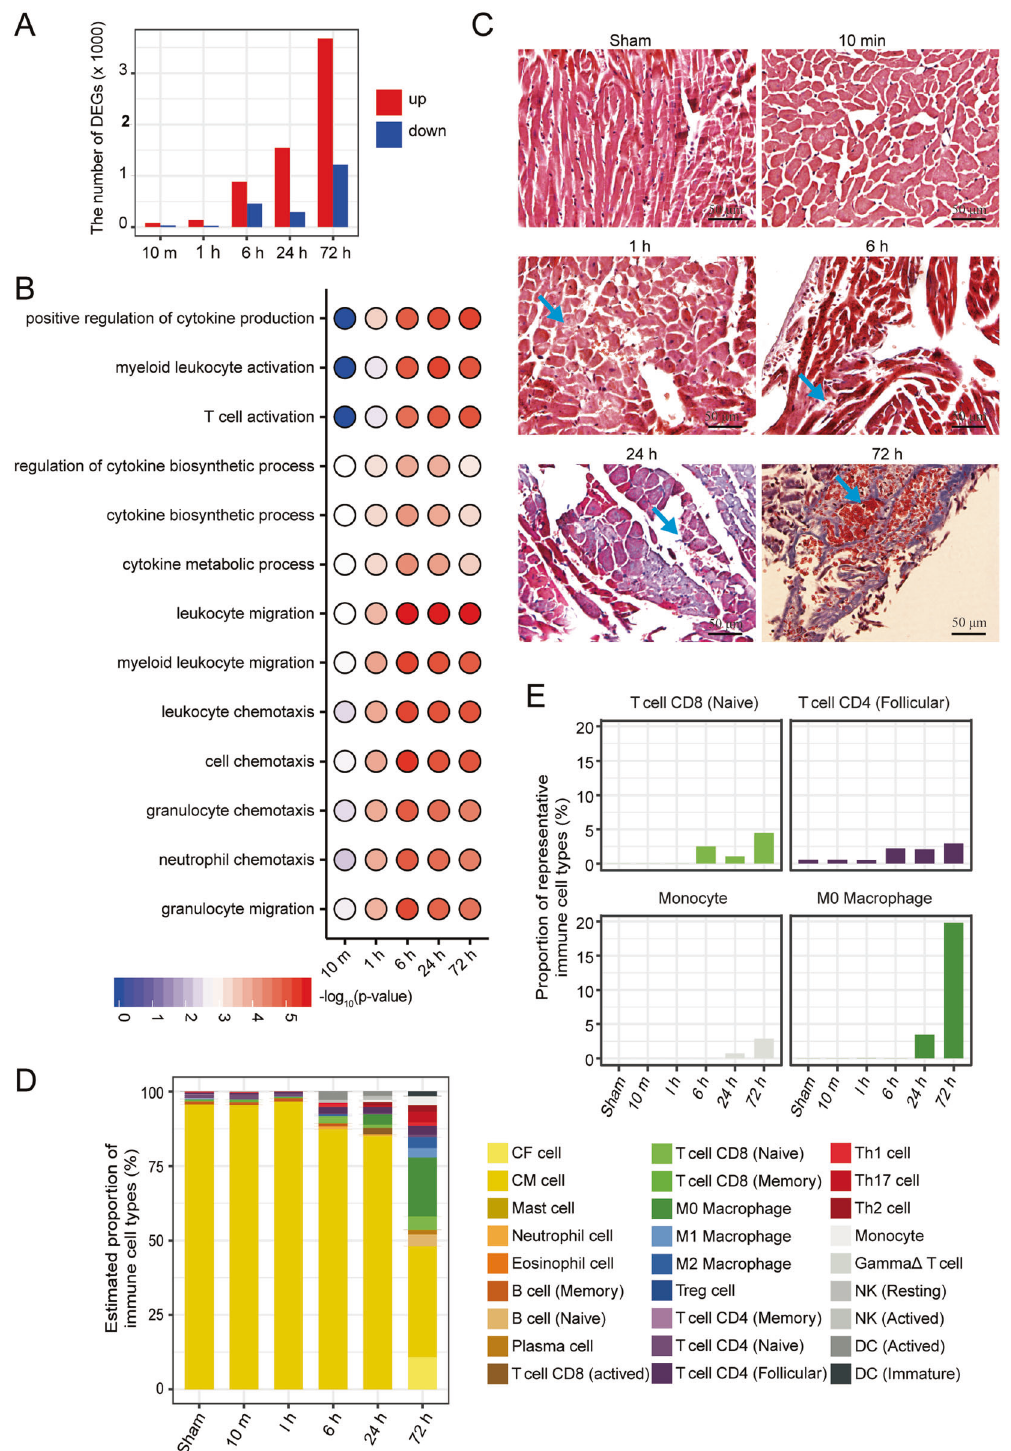
Fig. 2 Immune response at the early stage of AMI. A The number of the differentially expressed genes (DEGs) between AMI samples and the control sample. Red: upregulated, blue: downregulated. B Bubble diagram shows the signi fi cantly enriched GO terms (biological processes) of upregulated DEGs. C Masson staining results show the morphologic changes in AMI samples compared to the control sample. The arrows indicate the damaged cardiomyocytes at 1, 6 and 24 h. At 1 h, the cytoplasm of the cardiomyocytes begins to swell, and then the cells begin to disintegrate at 6 h; the fi brosis were found around the cardiomyocytes at 24 h, and the space made by the dead cardiomyocytes was occupied by red blood cells and immune cells at 72 h (Bar = 50 μ m). D The composition of immune cells in the infarcted myocardia at different stages of AMI. CM cardiac myocytes, CF cardiac fi broblasts. E The dynamic proportion of the representative types of immune cells in the course of AMI development, indicating the activation of immune in fi ltration.